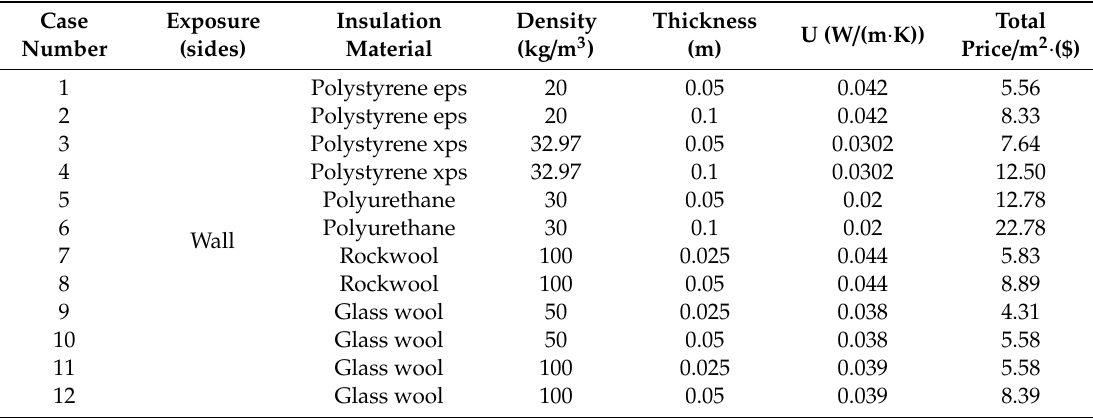
Table 5. Di ff erent insulation types and